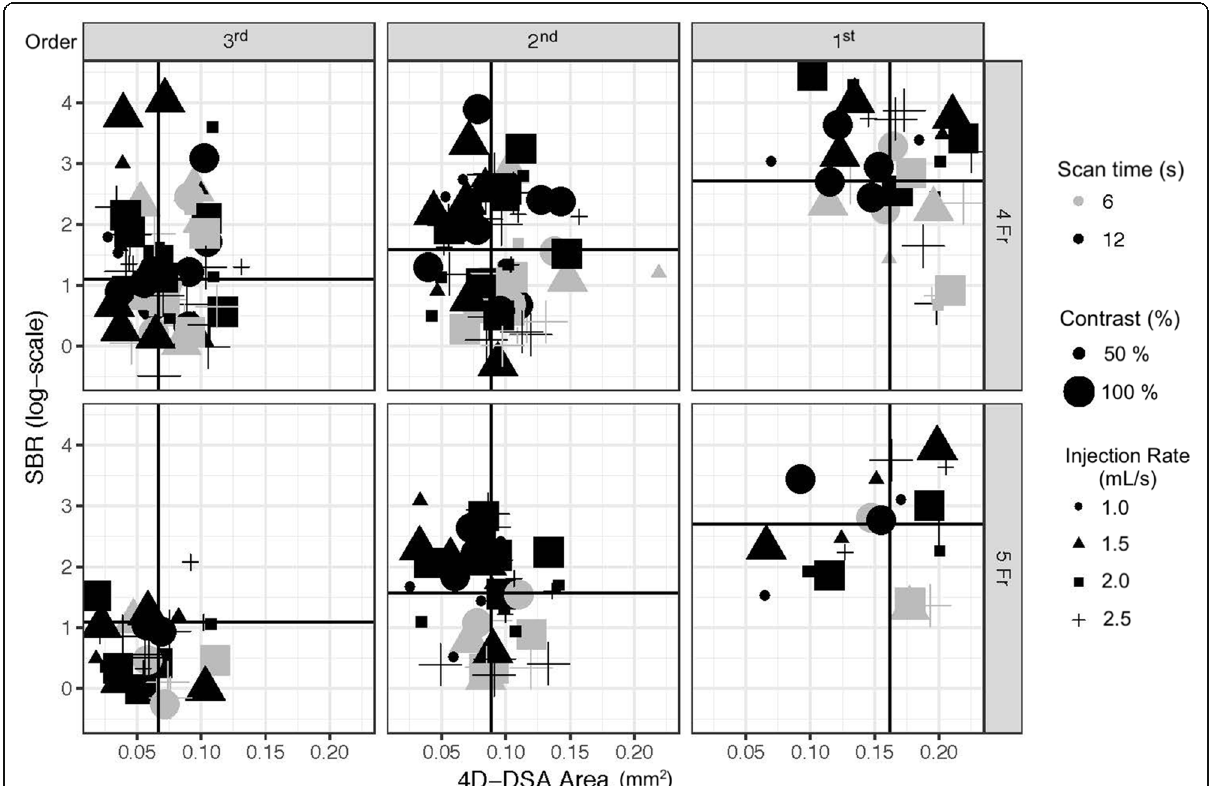
Fig. 2 Distribution of the combination of parameters affecting 4D-DSA area and sideband ratio (SBR). The dark x/y intercept lines represent the observed mean SBR and 4D-DSA area values for each